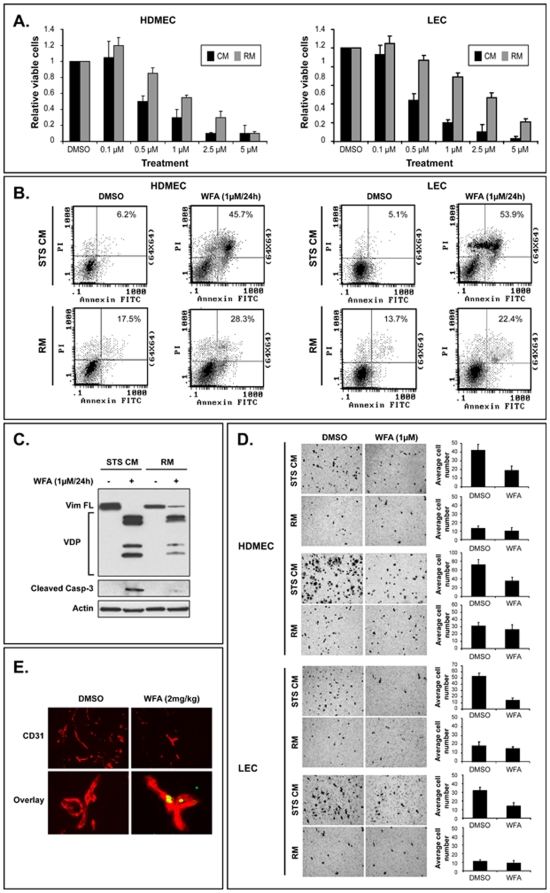
WFA induces apoptosis in endothelial cells cultured in STS-conditioned media.
A) A significantly higher rate of WFA-induced (24 h) growth inhibition is seen in endothelial cells (human dermal microvessel endothelial cells–HDMEC and murine lung endothelial cells–LEC) cultured in STS conditioned medium (CM) than in control regular medium (RM); B) WFA(1 µM/24 hr) induces higher levels of apoptosis in endothelial cells grown in STS-CM than in control medium; C) WFA (1 µM/24 hr) induces significantly higher rates of vimentin degradation and caspase-3 activation in endothelial cells grown in STS-CM than in quiescent endothelial cells; D) WFA (1 µM) abrogates migration and invasion of endothelial cells cultured in STS-CM; E) WFA (2 mg/kg) results in a significant decrease in the mean number of CD31-positive (red) blood vessels compared to control DMSO treatment in an in vivo gelfoam assay. CD-31(red)/TUNEL(green) double staining reveals endothelial cell apoptosis in WFA-treated mice. Graphs represent the average of three repeated experiments ±SD. (Vim FL  =  full length vimentin; VDP  =  vimentin degradation products)